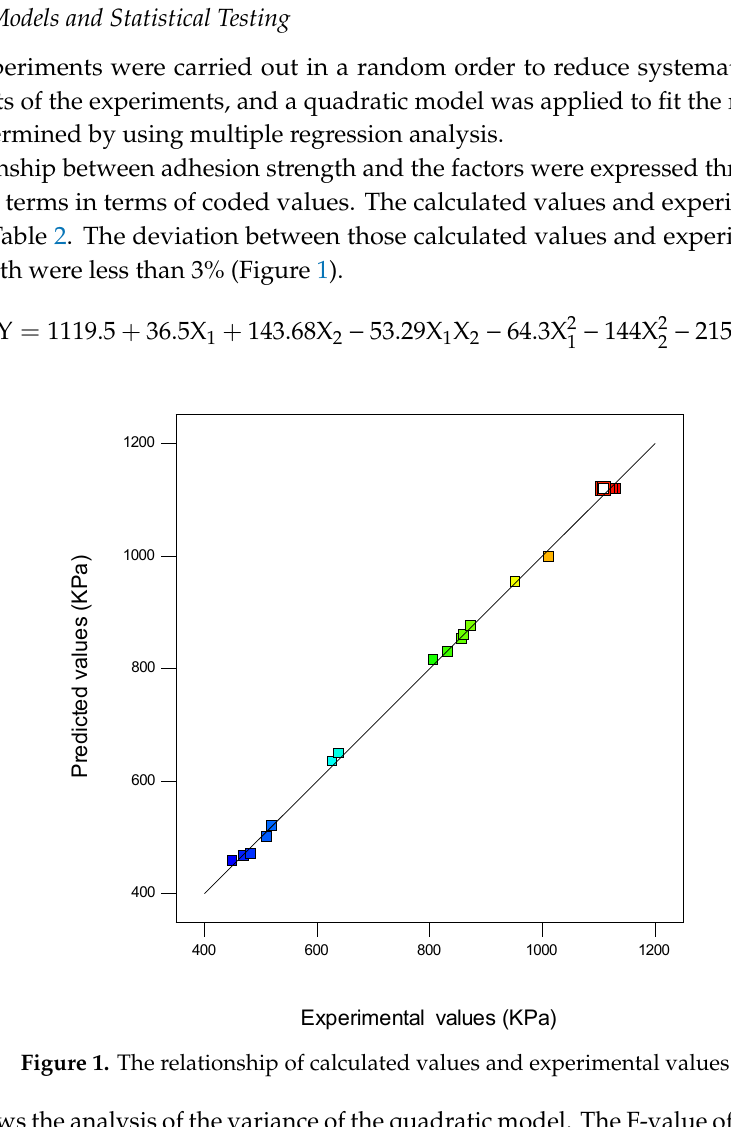
Table 3. Analysis of variance of the model regression for adhesion strength (Y).